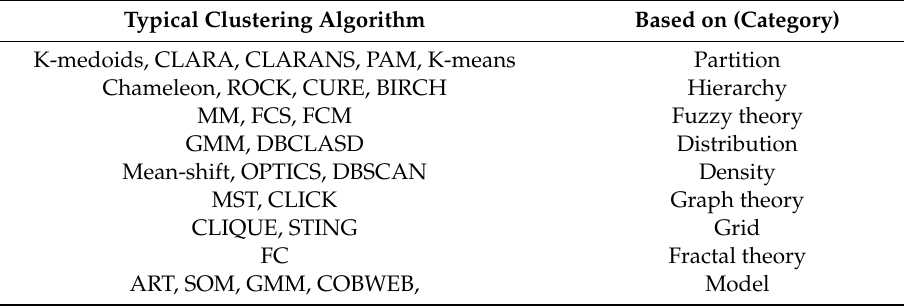
Table 1. Summarization of traditional clustering algorithms